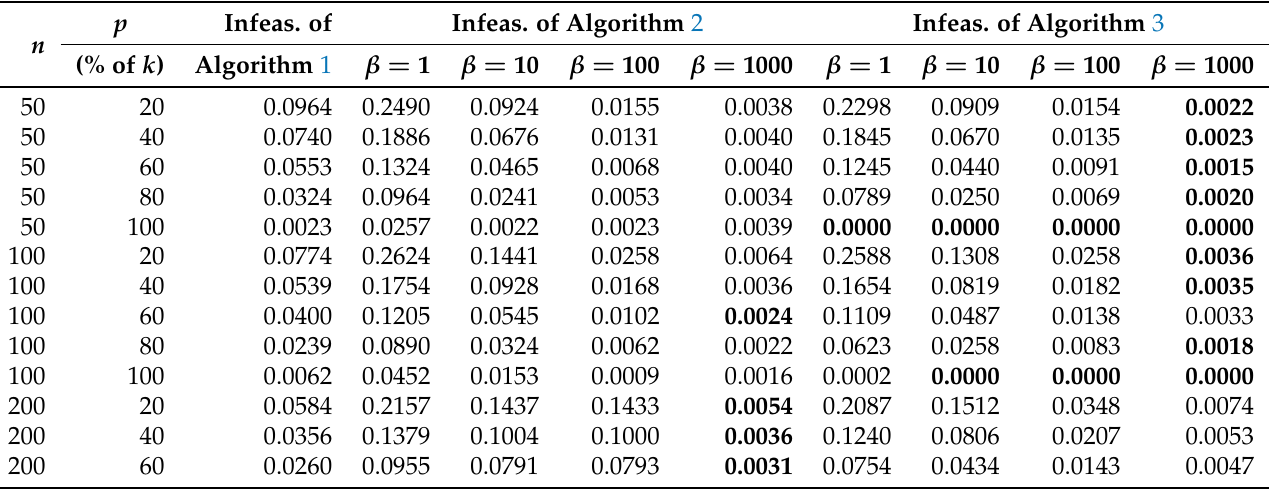
Table 3. In this table we demonstrate how feasible (orthonormal) the solutions are G computed by Algorithms 1–3 on UNION data set, i.e., in this table we report the average infeasibility of the solutions underlying Table 2. The bold number is the smallest one in each